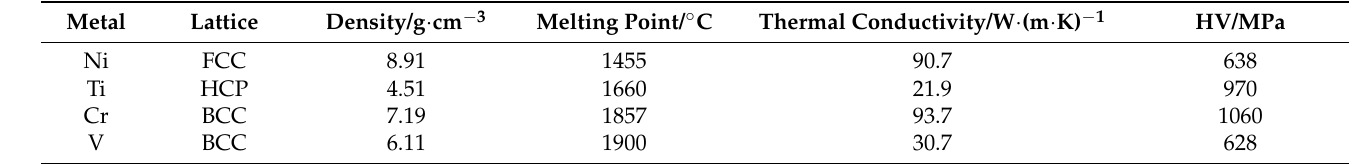
Table 4. Basic physical properties of Ni, Ti, Cr, and V (https://pt.kle.cz/zh_CN/index.html, accessed on 15 March